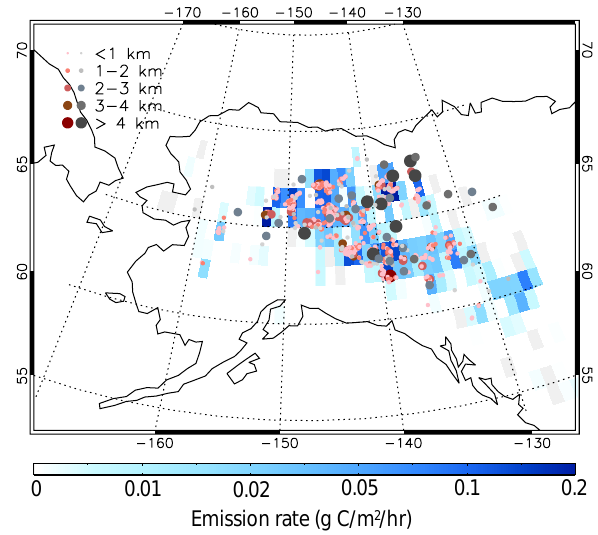
Fig. 2. Spatial distribution of GFEDv2 emissions (gC/m 2 /hr) in Alaska and western Canada during June–August 2004 (blue). Also shown are MISR-derived heights of smoke plumes (brown circles) and smoke clouds (grey circles). Data are from Nelson et al.